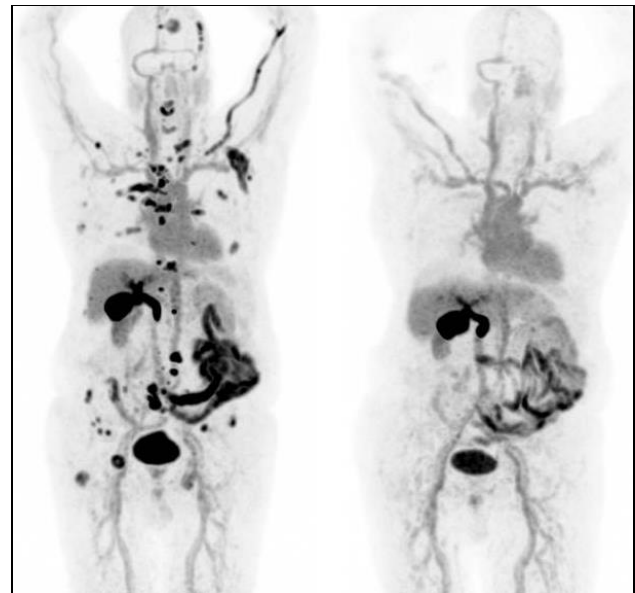
Figure 3. Example of [ 18 F]-FDHT-PET in a patient with metastasized prostate cancer: lymph nodes and bone metastases before (left) and during treatment with Enzalutamide.